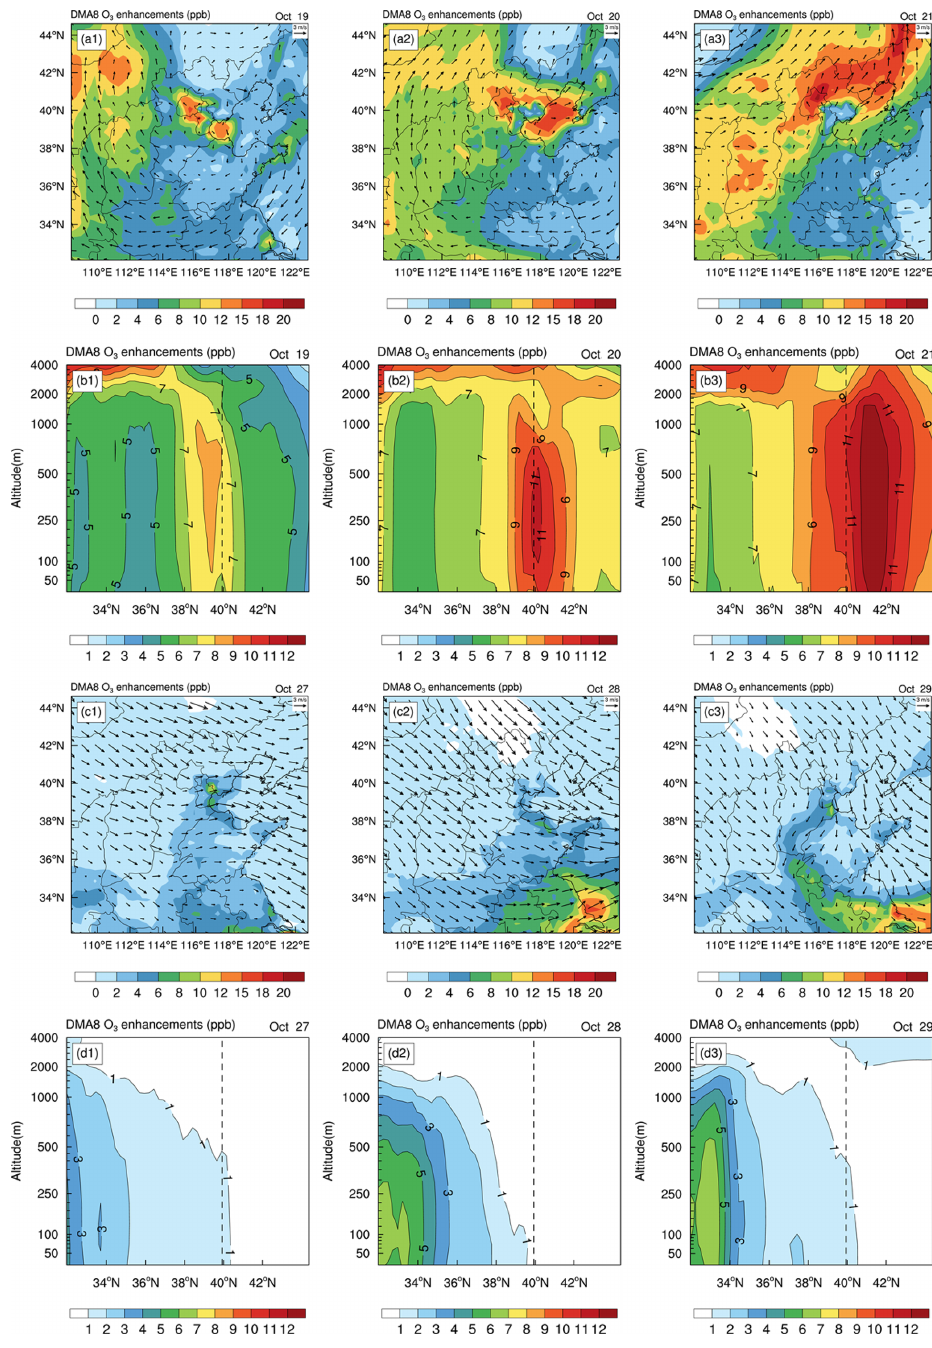
Figure 5. Surface-averaged ( a1 – a3 , c1 – c3 ) and zonal-averaged ( b1 – b3 , d1 – d3 ) DMA8 O 3 enhancements due to the six potential HONO sources in the North China Plain during a typical haze-aggravating process (19–21 October 2018) and a clean period (27–29 October 2018). The dashed line denotes the latitude of the BUCT